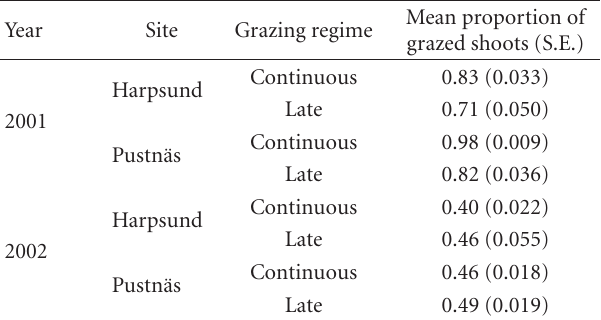
Table 1: The mean proportion of grazed shoots in mid-August in two grazing regimes (continuous stocking May-September and late grazing mid-July to September), at two sites (Harpsund and Pustn¨as), over two years, 2001 and 2002. N = 20 plots per grazing regime in Harpsund and N = 7 in